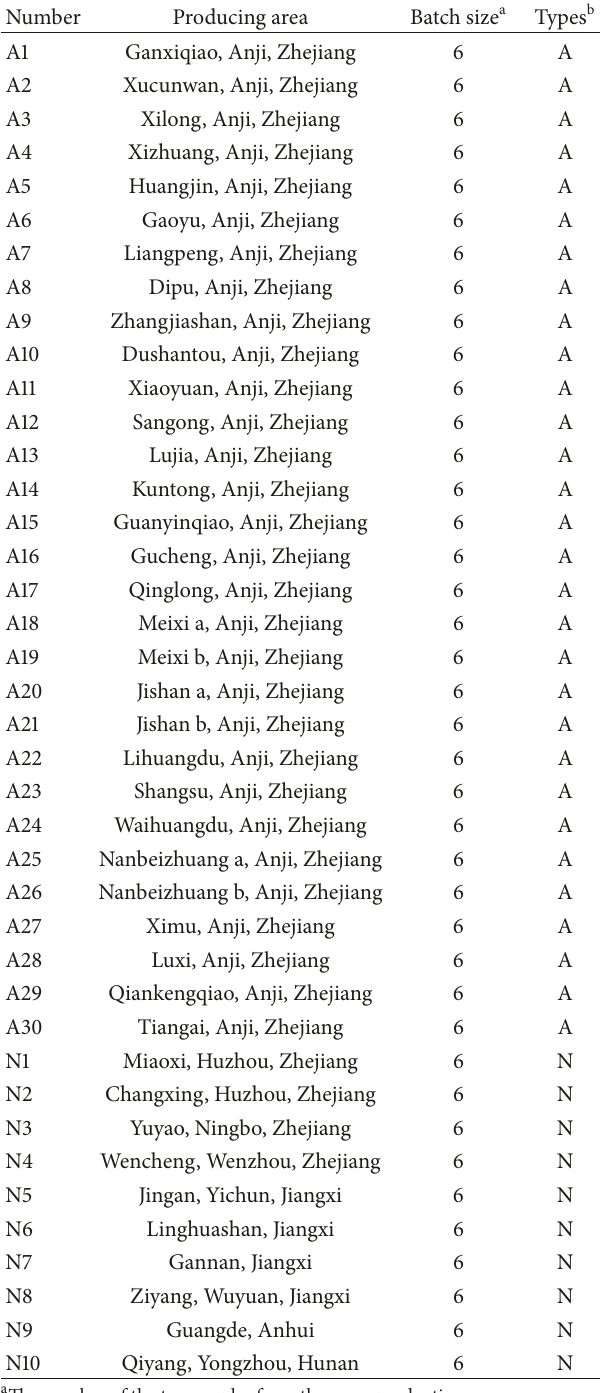
Table 1: Detailed information of the